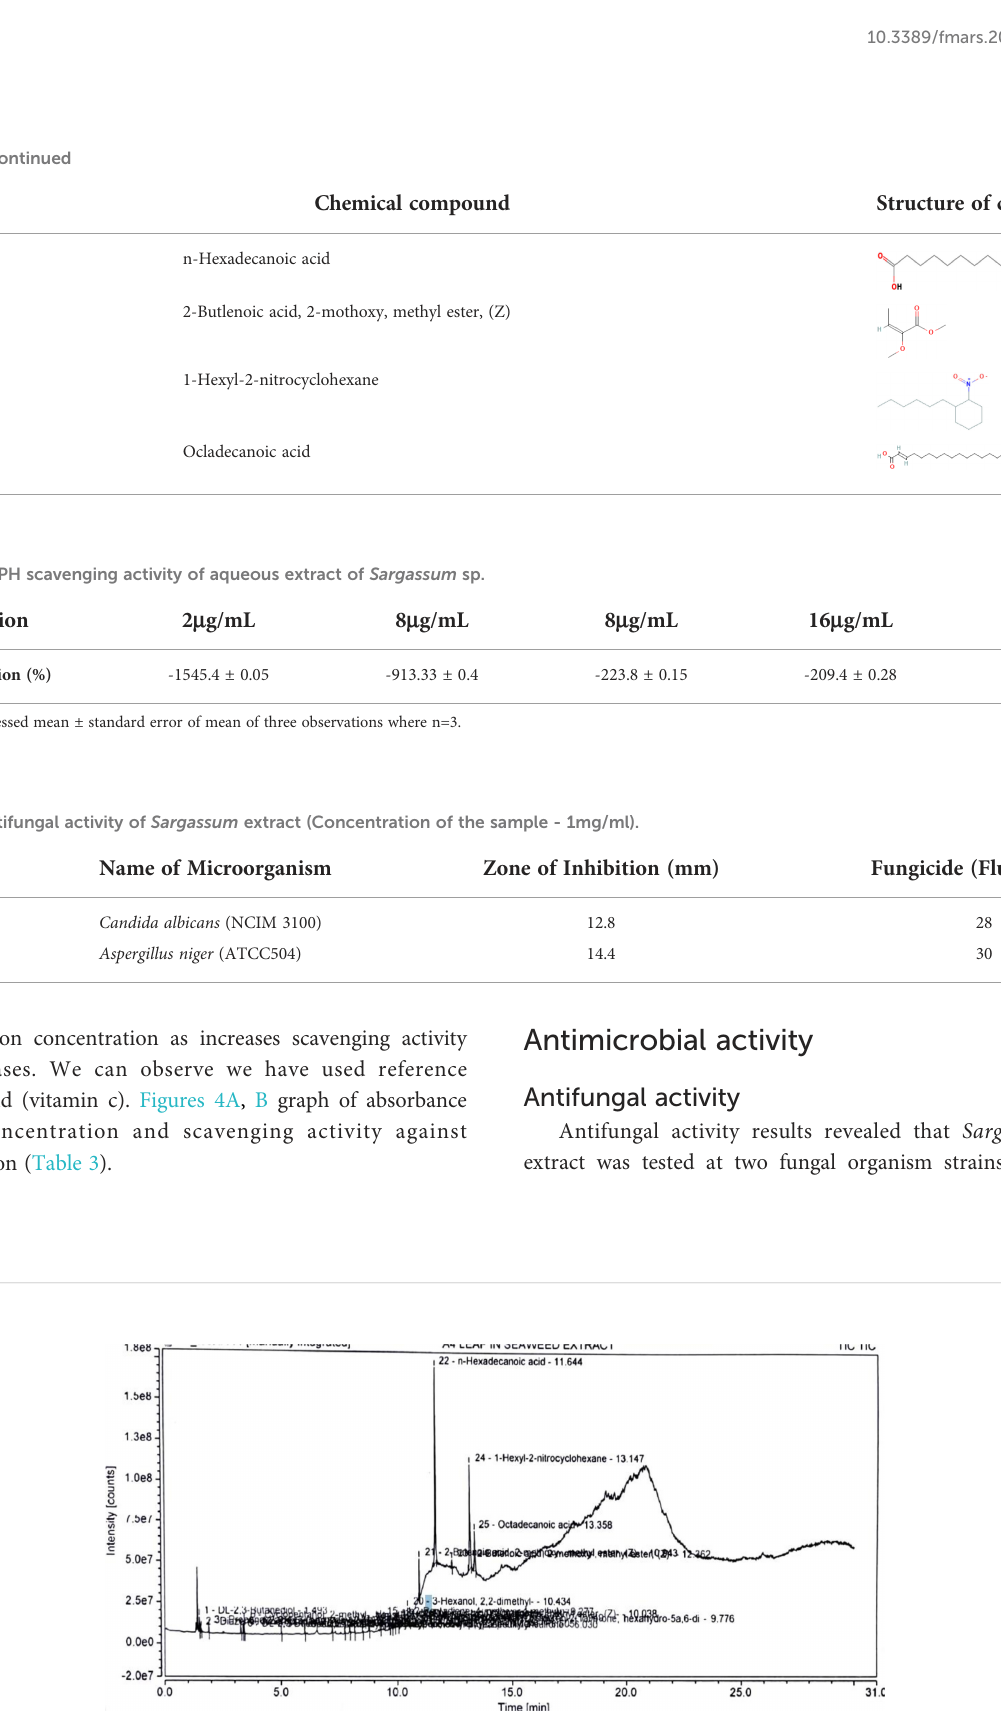
FIGURE 3 Gas chromatogram of Sargassum sp aqueous